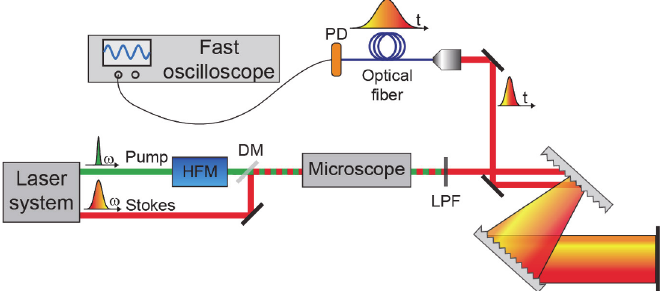
Fig. 2. Experimental setup of the PTS-SRS. HFM: high-frequency modulator; DM: dichroic mirror; LPF: long-pass filter; PD: photodiode.